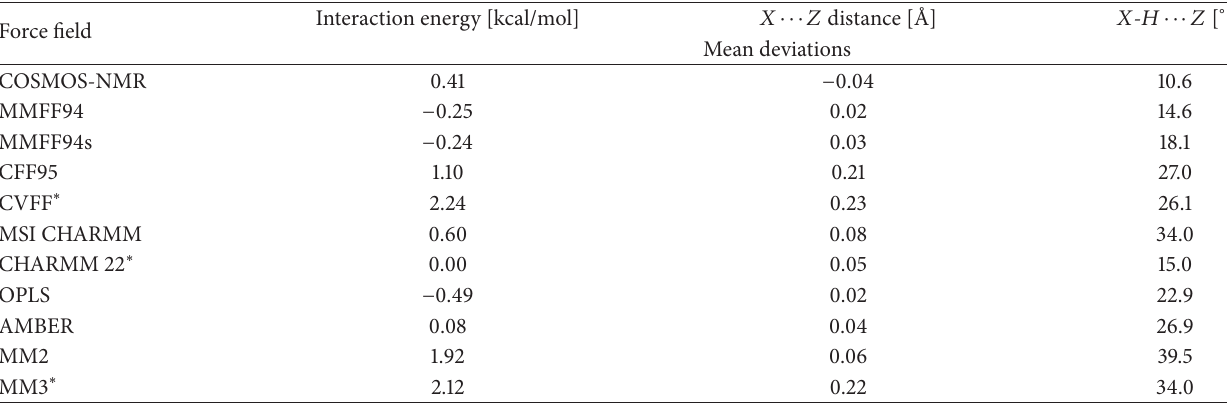
Table 2: Comparison of hydrogen-bonded dimer geometries and interaction energies to HF/6-31G ∗ data (this table is an extension of a web-based force field evaluation suite by Halgren [81–83] and compares the COSMOS-NMR force field with data provided by the web page http://server.ccl.net/cca/data/ff evaluation